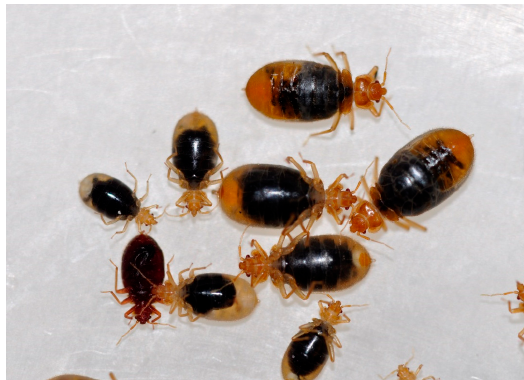
Figure 1. Bed bugs died after ingesting moxidectin-treated rabbit blood. Picture was taken seven day after treatment.